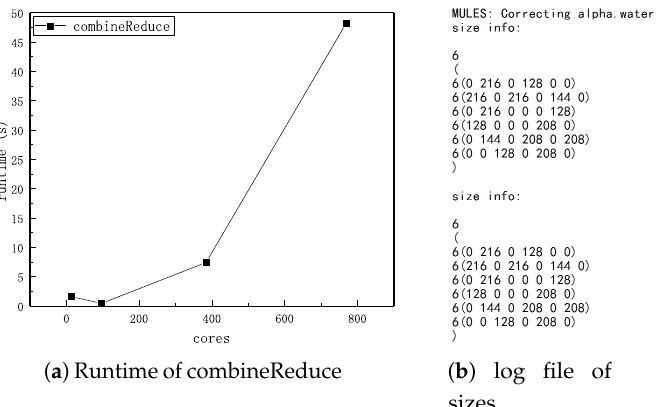
Figure 2. The verification test. ( a ) records the overhead of combineReduce on different cores. The test case and its working condition are the same as that in Figure 4; ( b ) details the information of message sizes in damBreak case on six